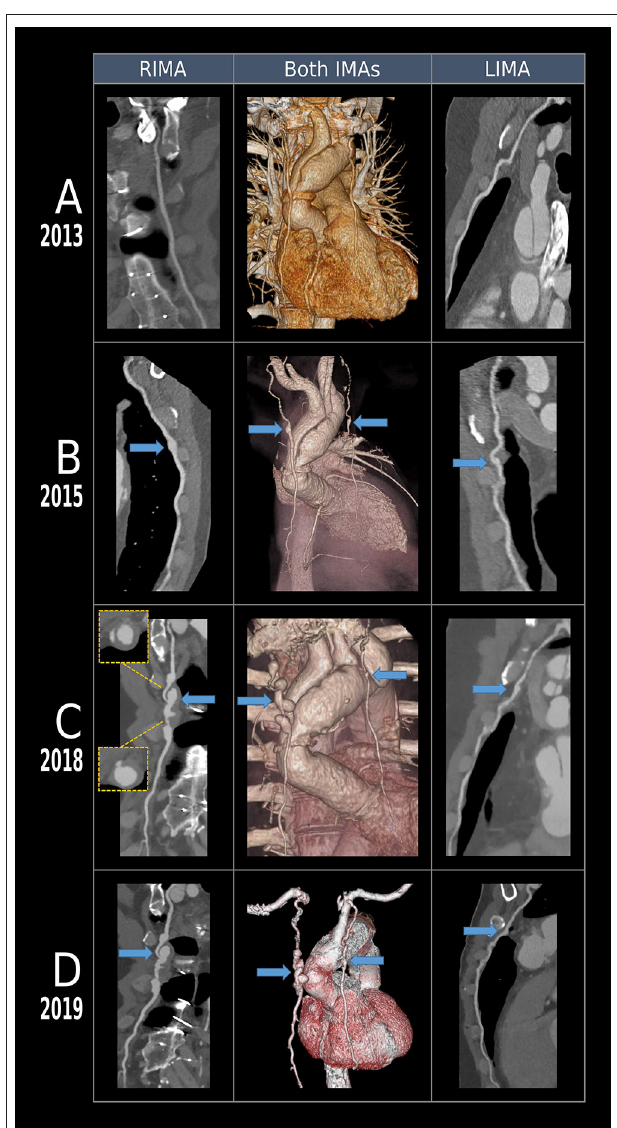
FIGURE 1 | Volumetric and multiplanar reconstructions of the aorta, left and right internal mammary artery (IMA) of a Marfan syndrome patient after Bentall procedure. 256-slice CT angiography of the chest was performed at three different timepoints. (A) In 2013, left and right IMA-s were intact without any signs of aneurysms. (B) In 2015, both arteries demonstrated a small dilatation ( ∼ 0.5cm) in the mid-section. (C) Follow-up scans after 3 years revealed a saccular pearl-string-like aneurysm of the right IMA with thrombus on the walls, an aneurysm of the left IMA and increase in diameter of the aortic arch. (D) Follow-up CT done in 2019 shows no progression of the